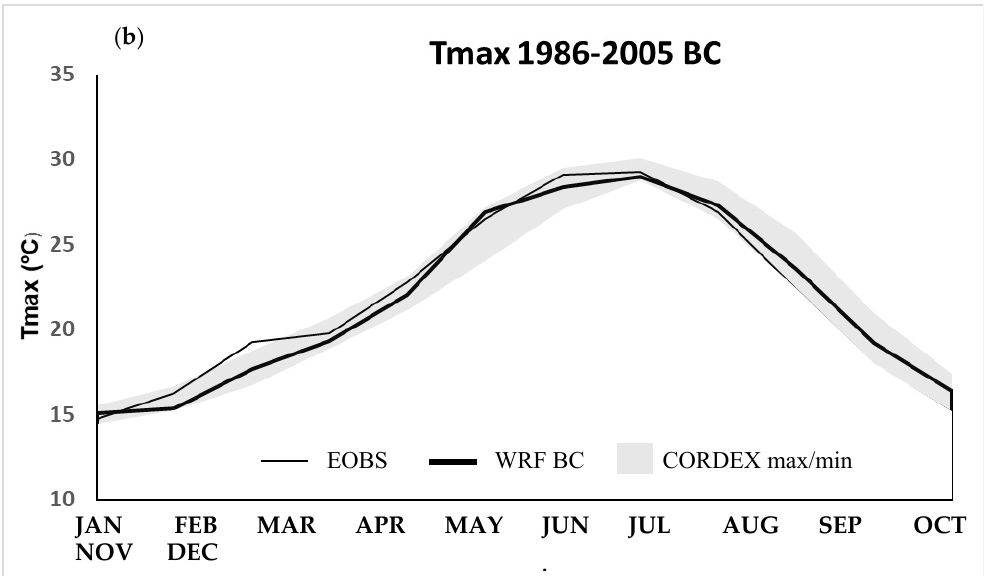
Figure 3. ( a ) Monthly averages of maximum temperature (Tmax) for the E-OBS Version 17.0 dataset (EOBS) and HIST for ( a ) raw uncorrected data (NC) and ( b ) bias correction (BC) data. The shaded ‘envelope’ represents maximum and minimum values across the CORDEX model ensemble. HIST: Simulation for the 1986–2005 period where the WRF was forced by the MPI-ESM-LR (Max Planck Institute Earth System Model—low resolution) (WRF-MPI) global climate model.